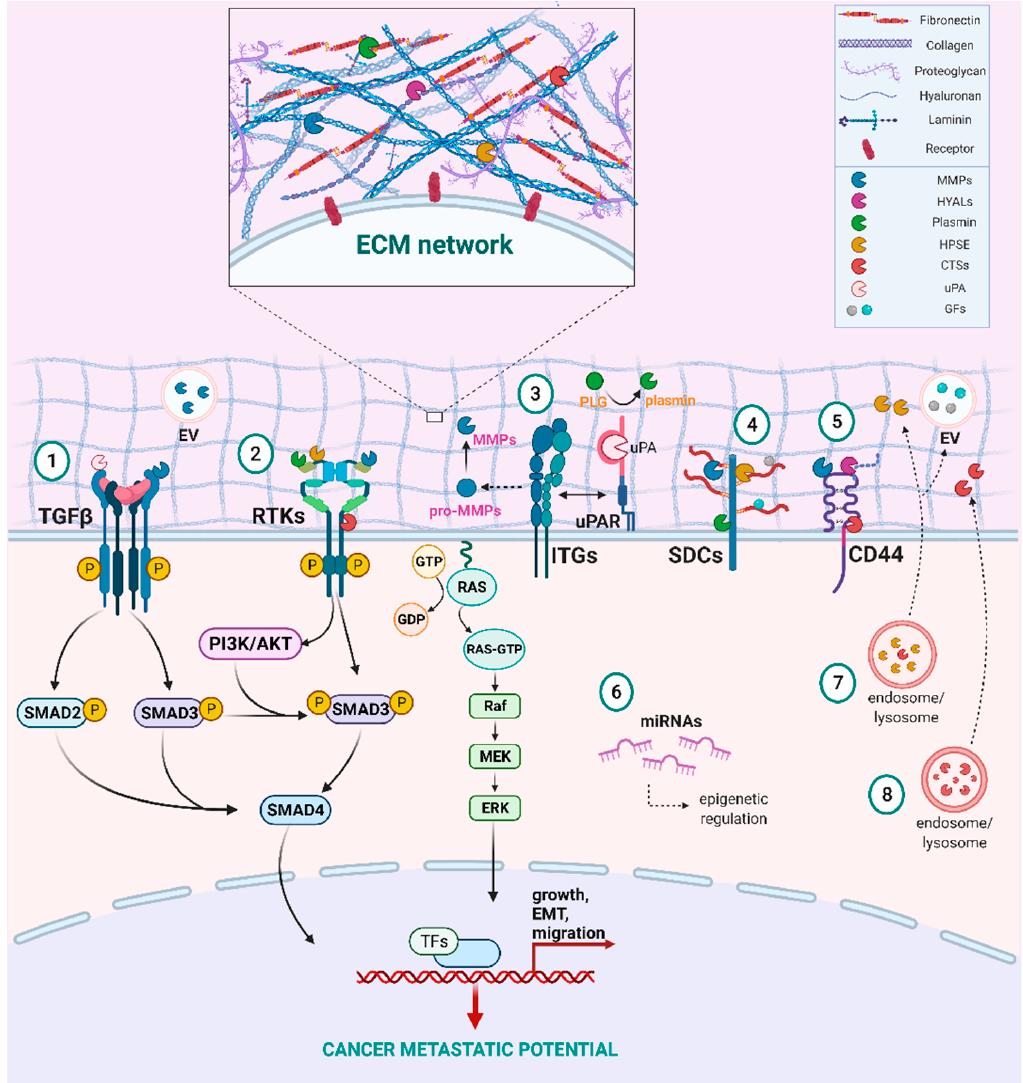
Figure 2. Main functions and signaling cascades mediated by matrix proteolytic enzymes. 1 (cid:13) TGF β induces the SMAD- dependent signaling to advance MMP expression. In turn, MMPs in the ECM, as well as uPA may promote the activation of TGF β to induce cancer-associated EMT. 2 (cid:13) Matrix remodeling enzymes interact with matrix effectors and affect RTKs activation, thus advancing downstream signaling cascades, like Ras-Raf-MAPK and PI3K/AKT, that lead to increased growth, migration and EMT. 3 (cid:13) Integrins, major receptors responsible for cell adhesion, contribute to the conversion of pro-MMPs to their active forms. Besides, integrins also facilitate MMP synthesis and regulate their expression levels. Integrin signaling can also regulate the expression and localization of uPA and uPAR, while uPAR interacts with integrins and could act as co-receptor to induce migration and invasion. 4 (cid:13) Plasmin accelerates syndecan (SDC) ectodomain shedding. 5 (cid:13) HYALs degrade HA, altering its molecular size and initiating different biological responses, following HA binding to receptors such as CD44. 6 (cid:13) miRNAs are critical regulators of matrix partners, either by inhibiting or promoting their expression. 7 (cid:13) HPSE is activated in late endosomes and lysosomes by cathepsin L and stimulates the biogenesis and secretion of exosomes. Additionally, HPSE can be secreted in the ECM under the proper stimuli. 8 (cid:13) Cathepsins reside in the lysosomes and upon rupture of the lysosomal membrane they are secreted in ECM to exert their actions. On the plasma membrane, they can shed the ectodomains of cell receptors and cleave growth factors and proteins (integrins, E-cadherin etc.). This figure was created using the tools available by BioRender.com, accessed on 2 February